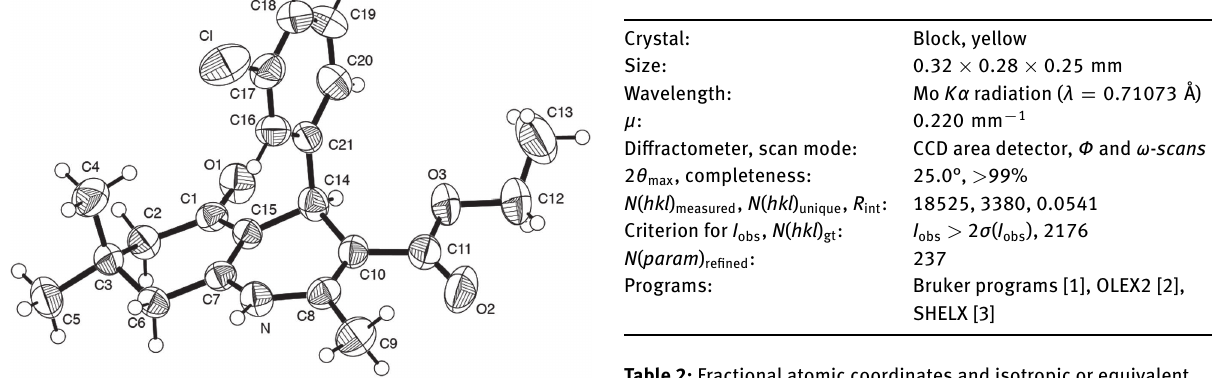
Table 1: Data collection and handling.